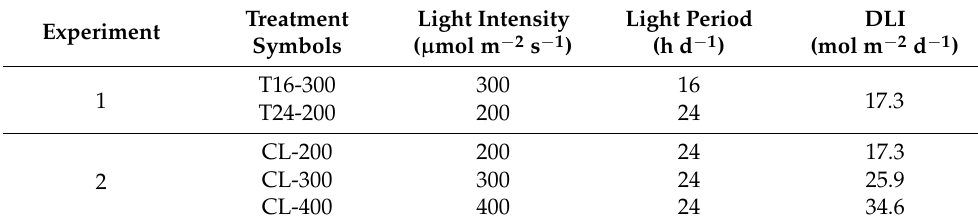
Table 1. Two lighting treatments for the same level of the daily light integral (DLI) created by different combinations of light intensity and the light period in Experiment 1, and three lighting treatments for different levels of the DLI created by different light intensities under the condition of continuous lighting (CL) in Experiment